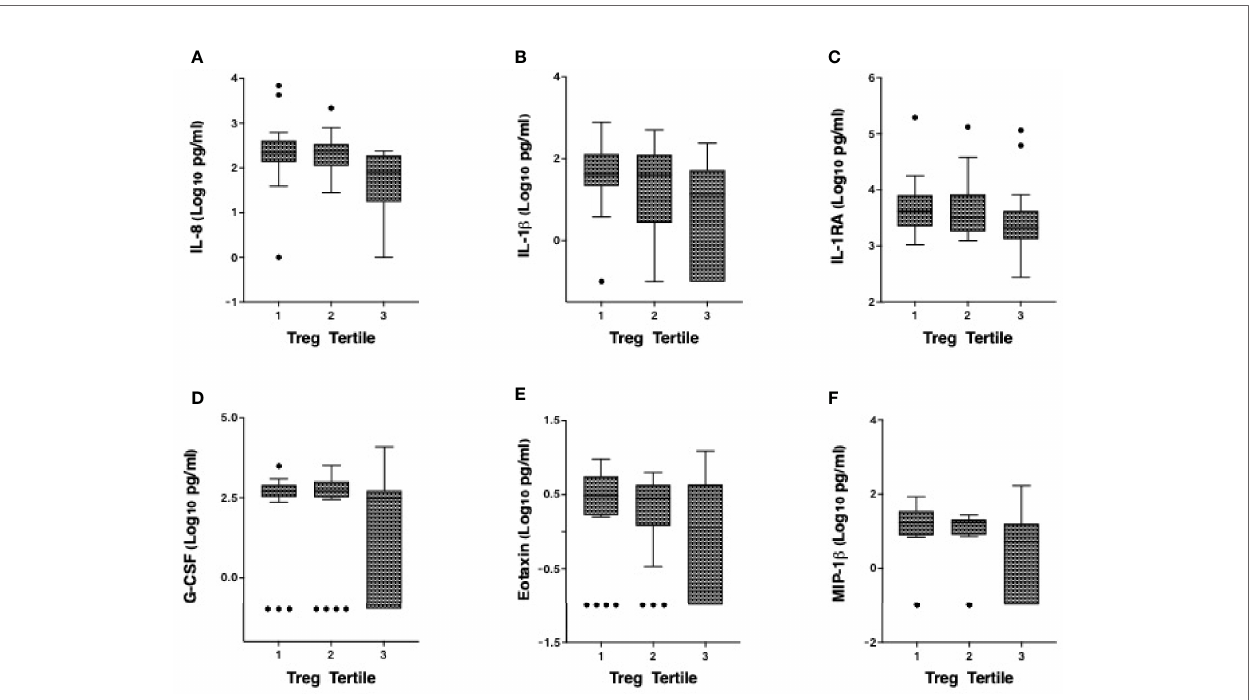
FIGURE 3 | Correlation of the cervicovaginal Treg frequency with genital cytokine/chemokine concentrations. Concentrations of (A) IL-8 (B) IL-1 b (C) IL-1RA (D) G- CSF, (E) Eotaxin and (F) MIP-1 b by endocervical Treg tertile with 1 consisting of participants with the lowest Treg cell counts and 3 with the highest Treg cell counts. For statistical analysis, see Table 3 .